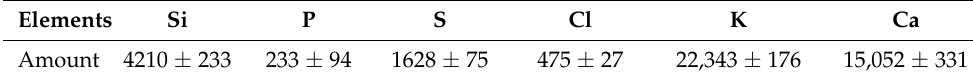
Table 2. The content of selected inorganic elements in studied biomass [mg · kg − 1